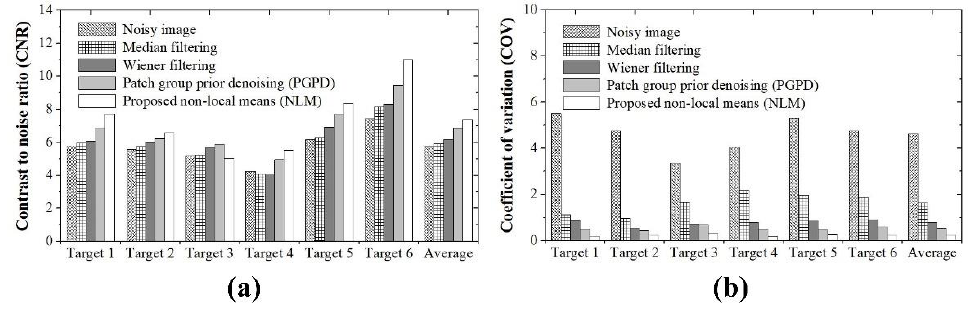
Figure 5. Graphs for quantitative evaluation of ( a ) CNR and ( b ) COV in acquired ATS ultrasound phantom images.